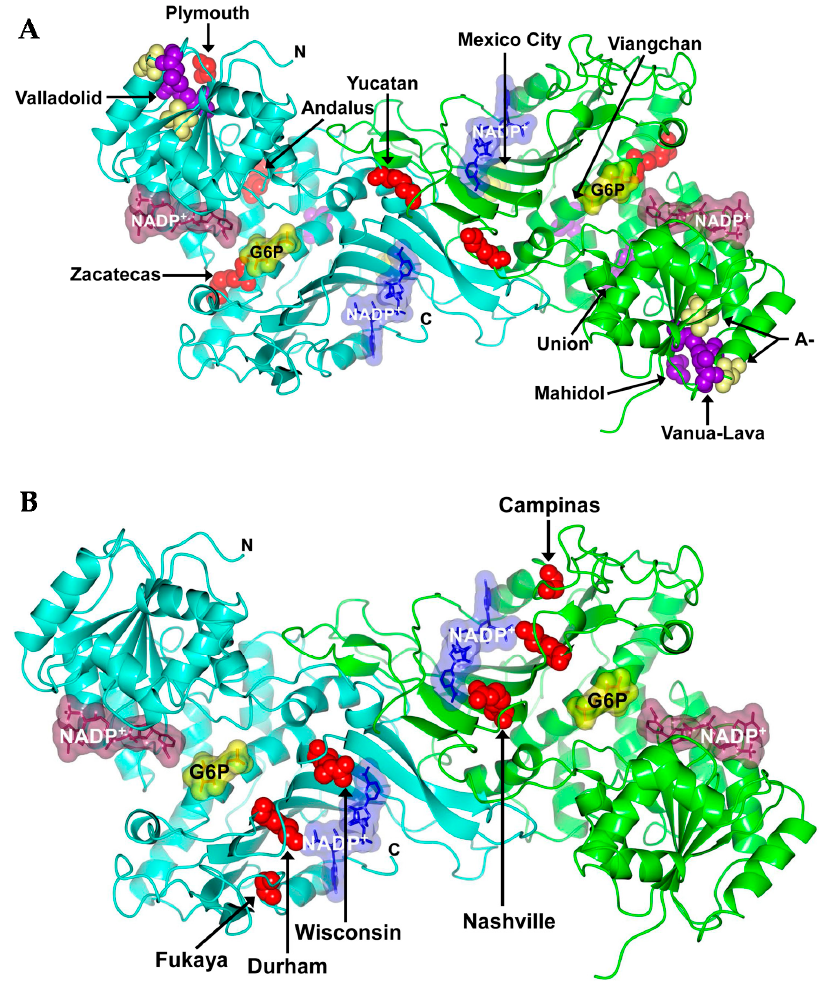
Figure 3. Position of mutations in G6PD affecting its thermostability. Location of Class I (red spheres), Class II (purple spheres), and Class III (yellow spheres) mutations in G6PD structure that showed ( A ) a protective; and ( B ) not protective effect when NADP + was increased. Note that although most of the mutants are located on equivalent positions of G6PD dimer, Fukaya, Campinas, Wisconsin, Nashville, Plymouth, Mahidol, Union and Andalus mutants are shown in only one of the monomers.